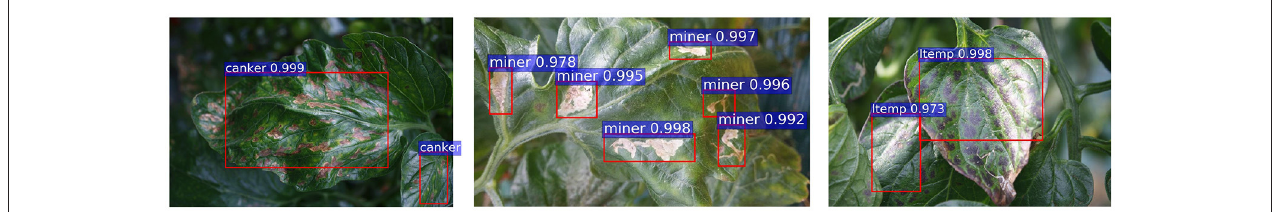
FIGURE 3 | A representation of bounding boxes with various sizes for different detected classes.